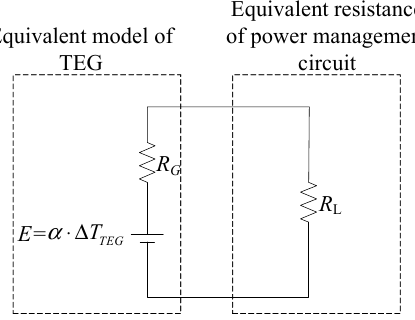
Figure 1. The equivalent electrical model of the TEG [23].